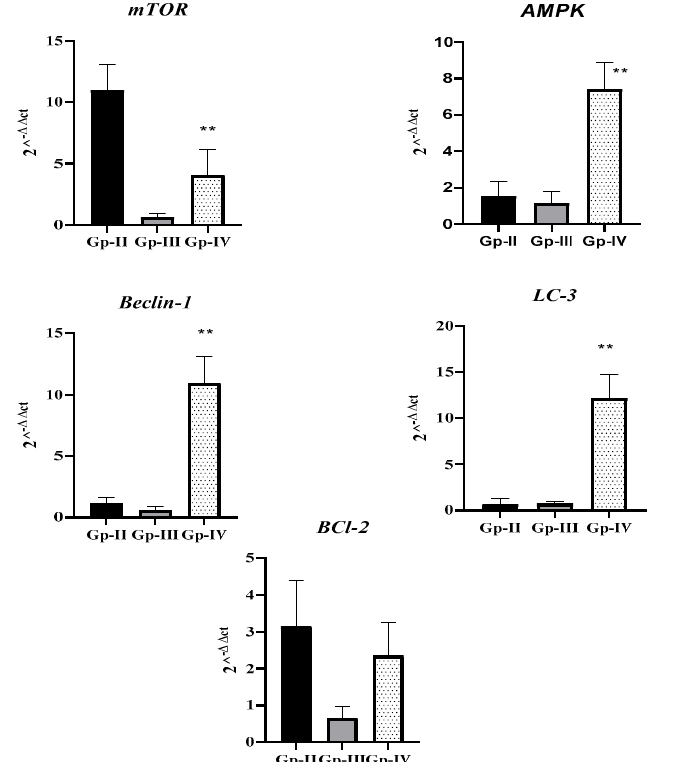
Figure 5. Relative quantification (RQ = 2ˆ − ∆∆ ct) of tumor marker BCl-2 and autophagy markers (mTOR, AMPK, Beclin-1, and LC-3) in different animal groups, in relation to Gp-II (DEN group). Gp-II: Group II, treated with diethylnitrosamine; Gp-III: Group III, treated with A. gigantea ; Gp-IV: Group IV, treated with diethylnitrosamine combined with plant extract. Data represent the mean ± SEM. ** p < 0.01 indicates significant differences from the DEN group.